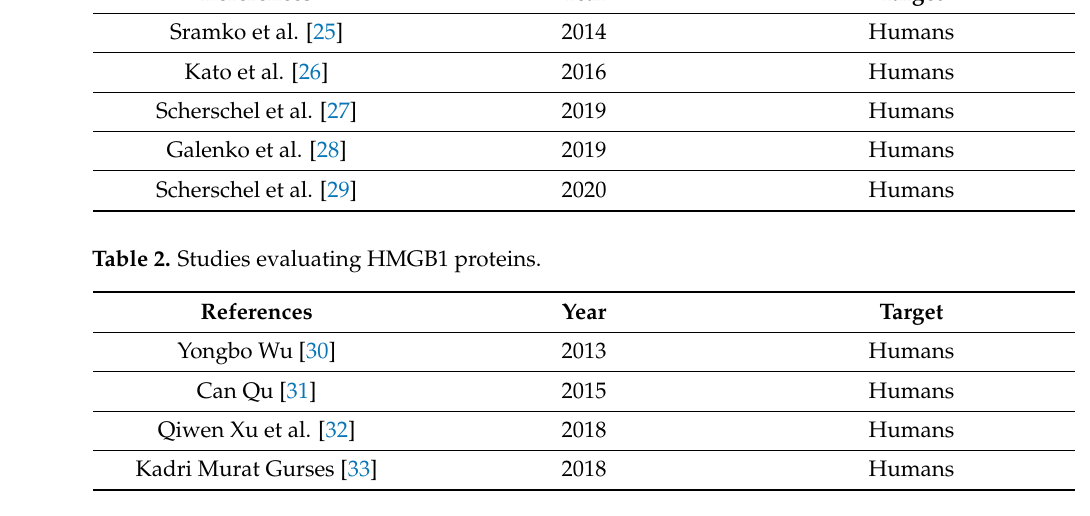
Table 3. Studies evaluating heat shock